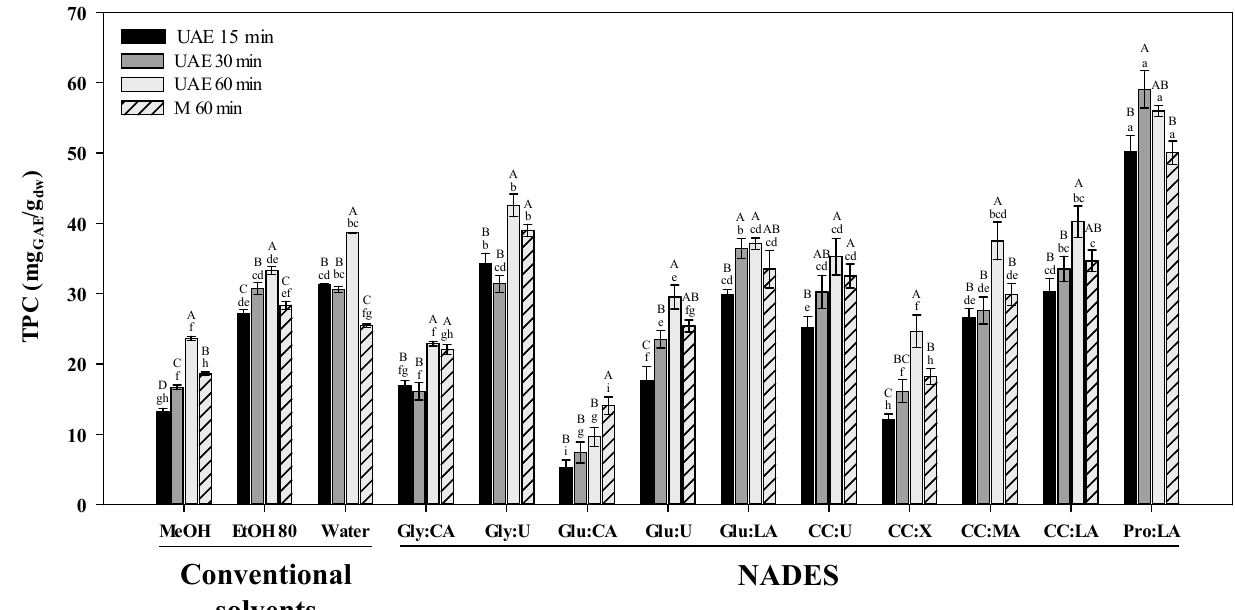
Figure 1. Effect of extraction technique (M: maceration and UAE: ultrasound-assisted extraction), extraction period (15, 30 and 60 min) and solvent (conventional and natural deep eutectic solvents, NADES) on total phenolic contents (TPC) of Lavandula pedunculata subsp. lusitanica extracts. The corresponding to the solvent’s abbreviations can be consulted in Table 1. Values are expressed as mean ± SE ( n = 3). Different letters in each series indicate significant differences ( p < 0.05), (Duncan’s new multiple range test). Uppercase letters indicate significant differences ( p < 0.05) between the four extraction conditions (M60, UAE 60, 30, 15) while lowercase letter denotes significant differences ( p < 0.05) between solvents.